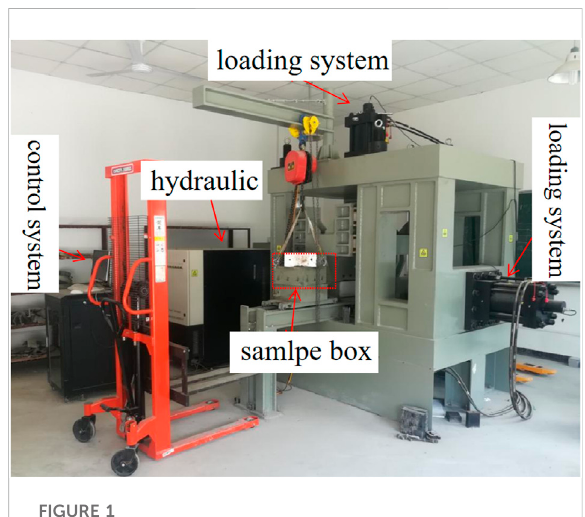
FIGURE 1 Multifunctional rock-soil contact damage test